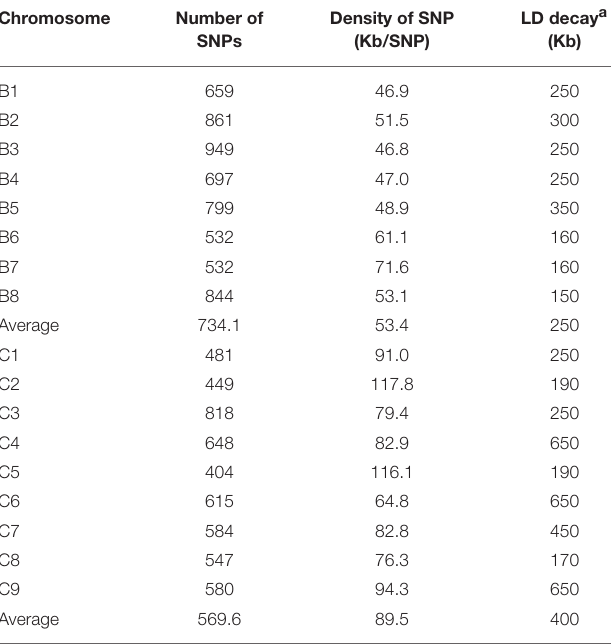
TABLE 1 | Summary of the polymorphic markers used for linkage disequilibrium estimation on the 17 chromosomes of B. carinata .